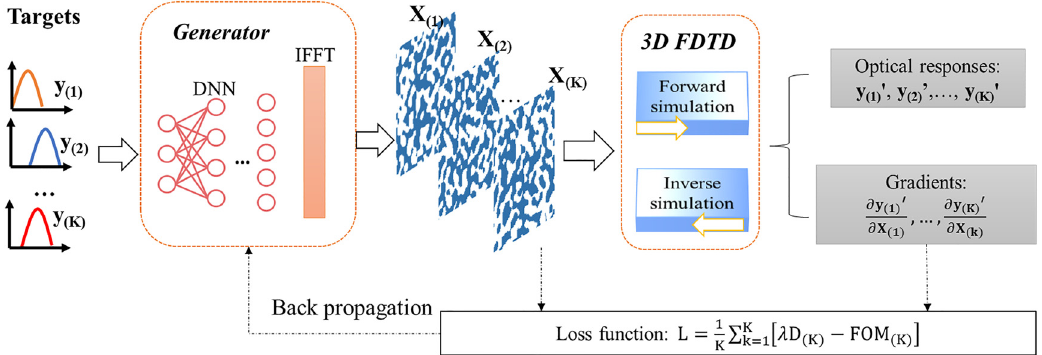
Figure 2: Schematic of the proposed DNN-assisted topology optimization in Fourier domain for multi-task optimization.